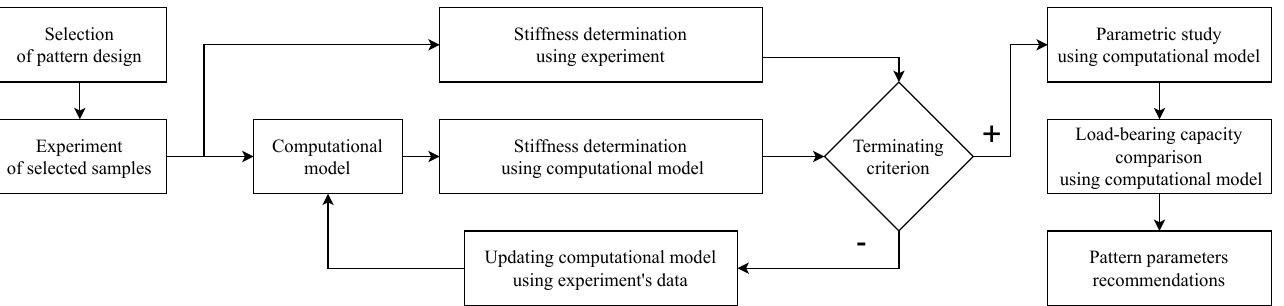
Figure 1. A diagram showing the research workflow of modeling and testing of flexible